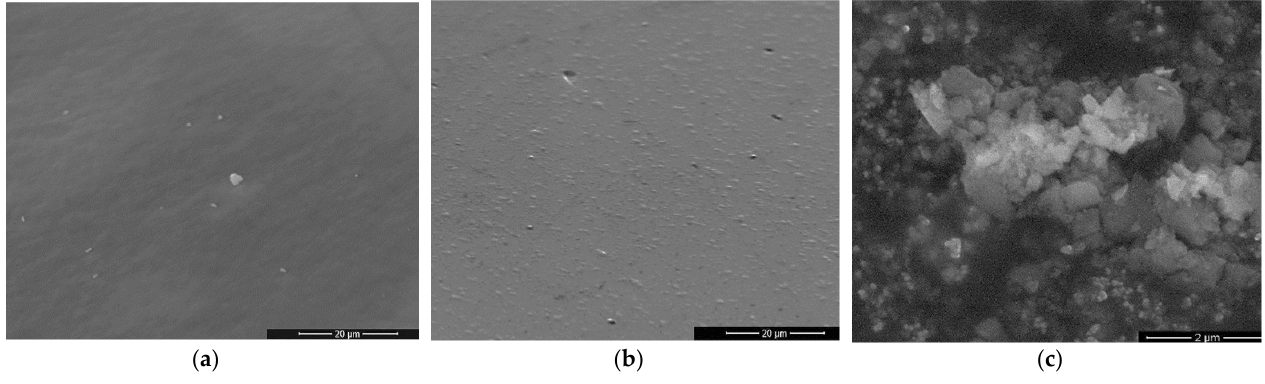
Figure 5. SEM images of heat-treated powders: ( a ) G1-900 °C (×4000), ( b ) G2-900 °C (×4000) and ( c ) G4-900 °C (×20,000).